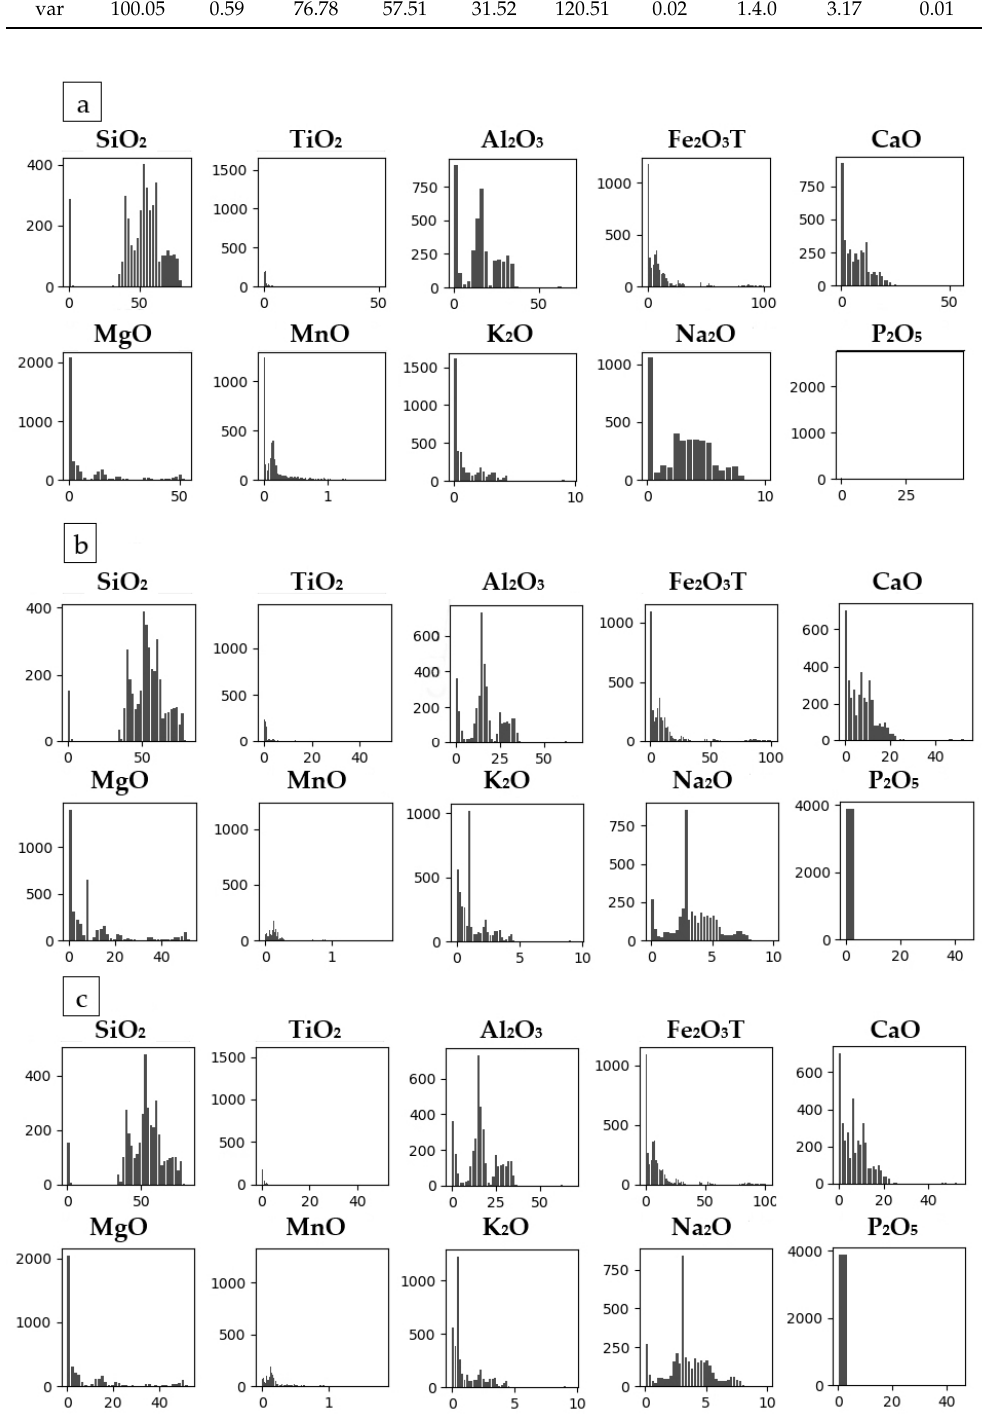
Figure 7. Histograms of the datasets with outliers: ( a ) Dataset 1, ( b ) Dataset 2, and ( c ) Dataset 3.